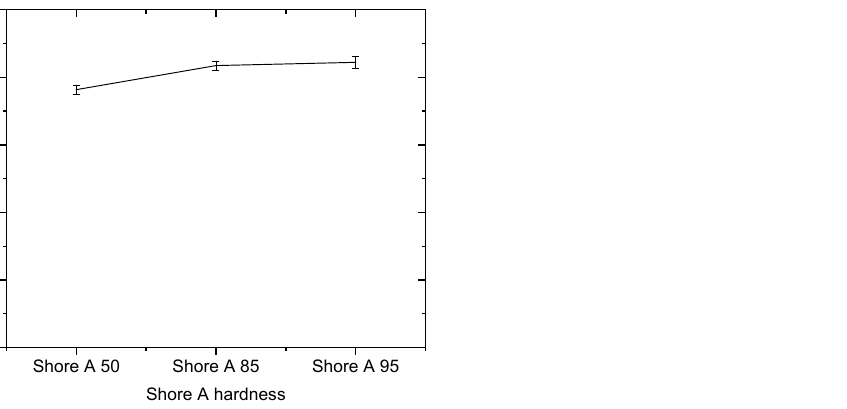
Figure 3. Contact angles of distilled water on Parylene C coated on substrates with different Shore A hardness values.